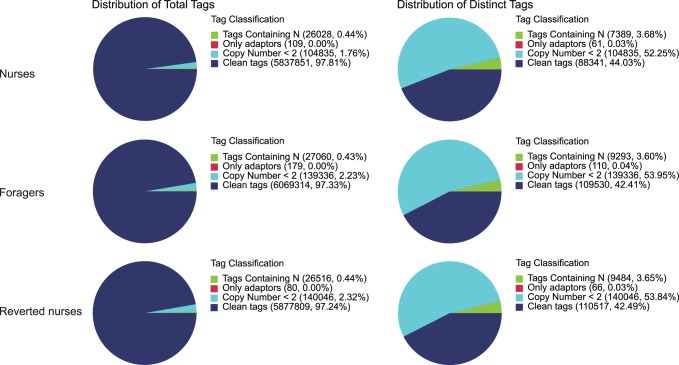
Distribution of total tags and distinct tags over different tag abundance categories in each sample.The numbers and percentage of tags containing N, empty tags with adaptor only, tags with copy number<2 and clean tags, are shown.